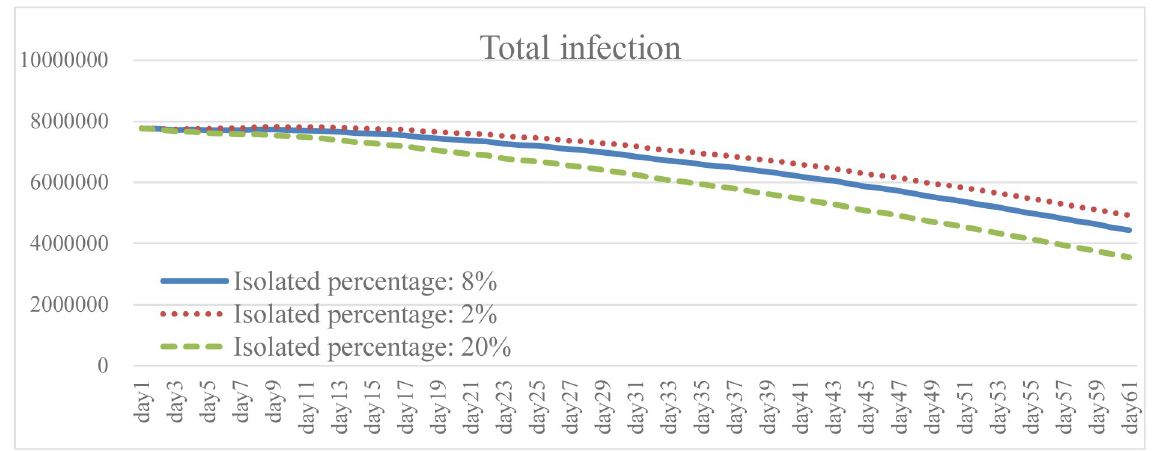
Fig 5. Total infection under different isolation